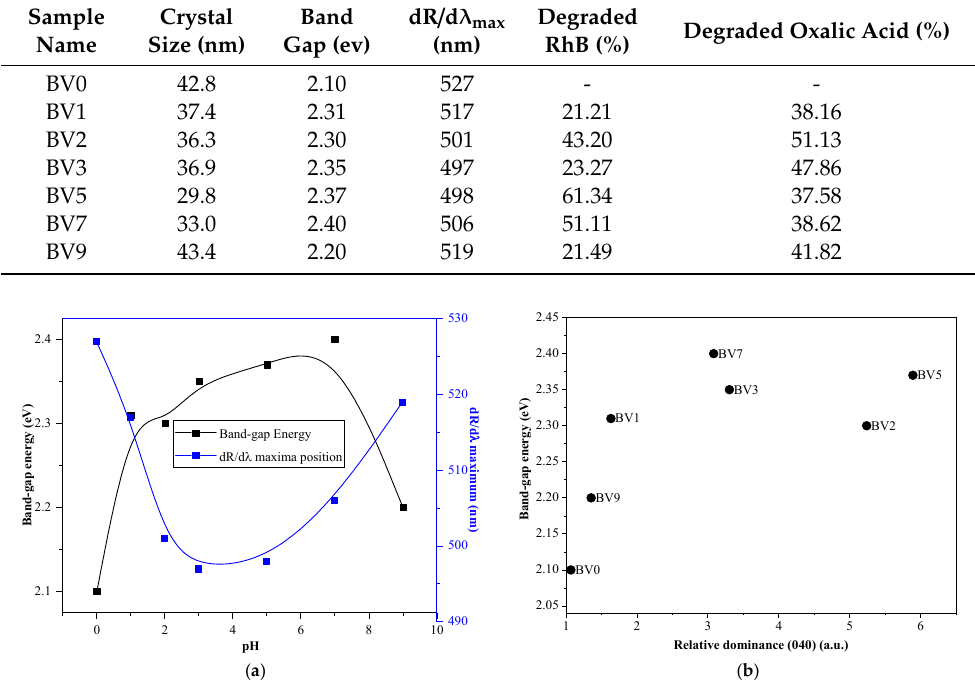
Figure 3. The band-gap value and the first derivative DRS spectra maxima changes in function of the synthesis pH ( a ). The band-gap value changes as a function of (040) crystallographic plane’s dominance ( b ).